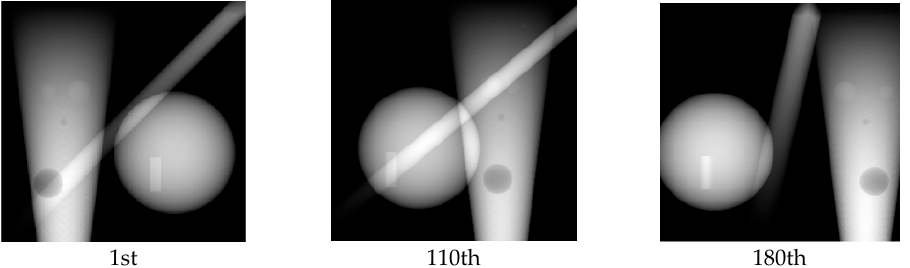
Figure 7. Three of the projections of the 3D data cube of Figure 6. The projections 1st, 110th, and 180th corresponding to rotation angle 0.7, 77, and 126 degrees.